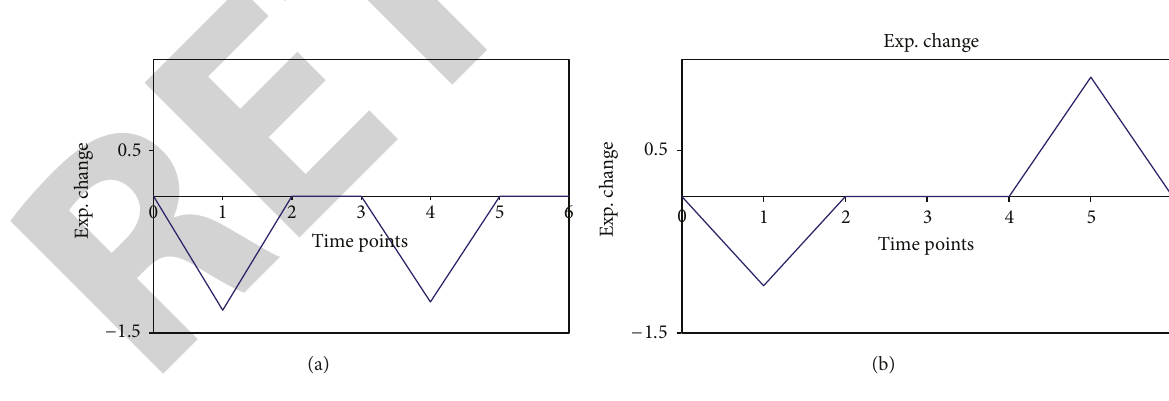
Figure 7: The expression trend graphs of gene 18 and gene 21 ( 𝑃 = 0